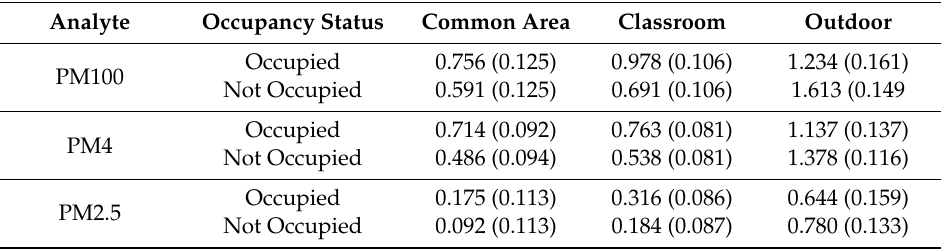
Table 3. Least squares mean average log concentrations of each size fraction of particulate matter by occupancy status and zone within buildings in µ g / m 3